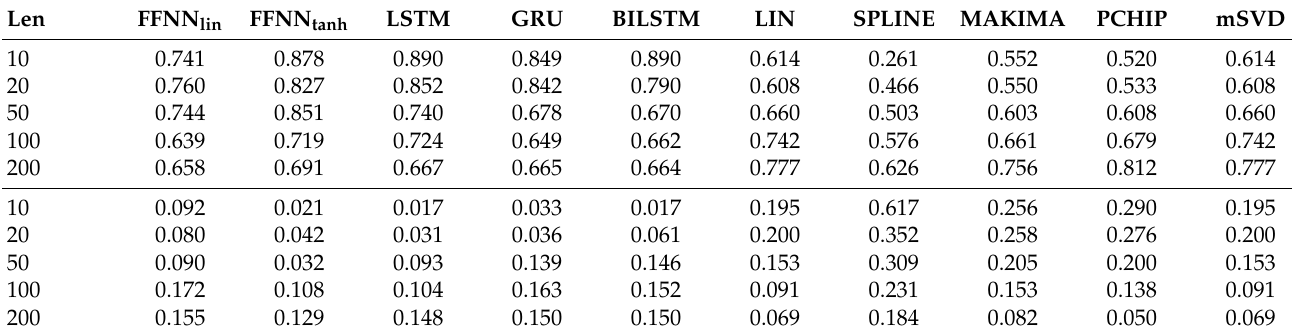
Table A6. Correlation between RMSE and entropy of input sequence.